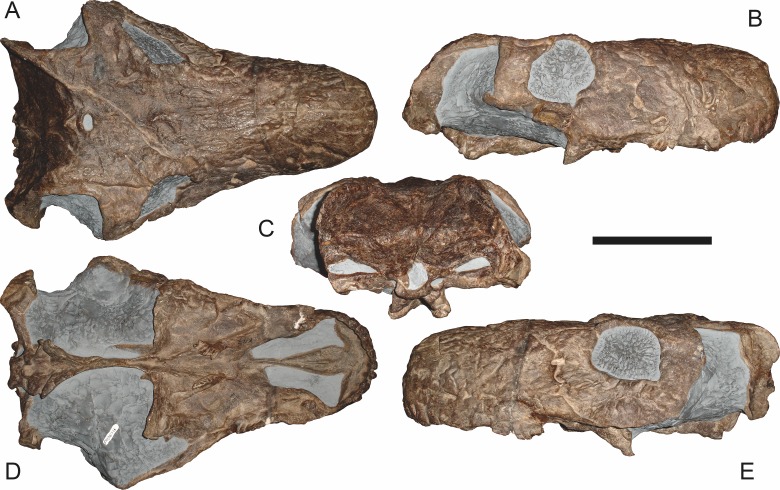
Referred specimen (GPIT/RE/7116) of Sycosaurus nowaki (Broili & Schröder, 1936) in (A) dorsal, (B) right lateral, (C) occipital, (D) ventral, and (E) left lateral views.Holotype of Lycaenops kingoriensis
Huene, 1950. Scale bar equals 10 cm.